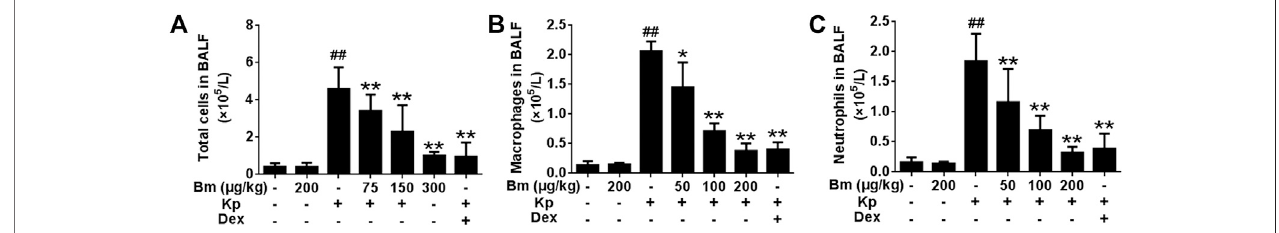
FIGURE 4 | Effects of Bergenin monohydrate on the number of total cells, neutrophils and macrophages after Klebsiella pneumonia infection (A) Statistics of total cells in BALF (B) Statistics of macrophages in BALF (C) Statistics of neutrophils in BALF. All data are presented as the means ± SEM ( n (cid:2) 5). ## p < 0.01 vs the Control group; * p < 0.05 and ** p < 0.01 vs the Klebsiella pneumonia group.